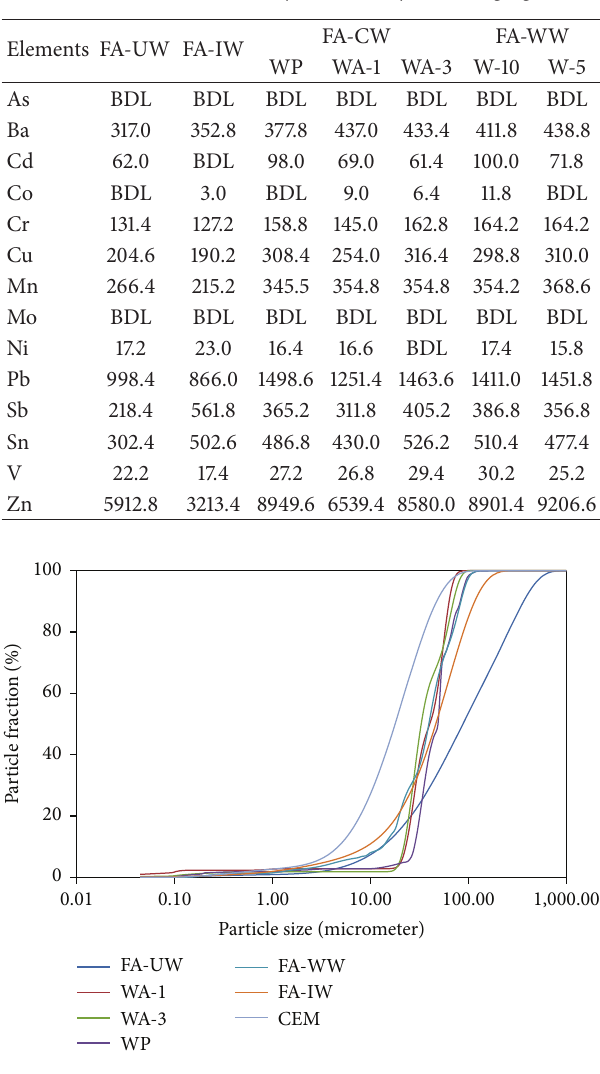
Figure 1: Particle size analysis of various treated